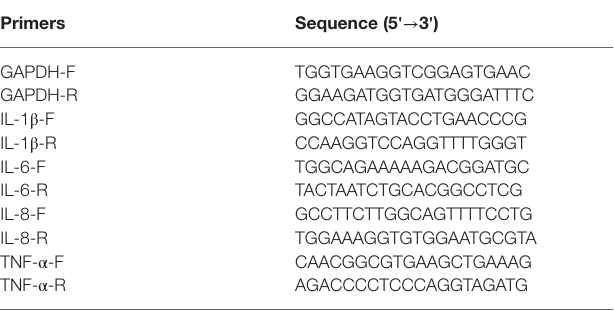
TABLE 1 | Primers for